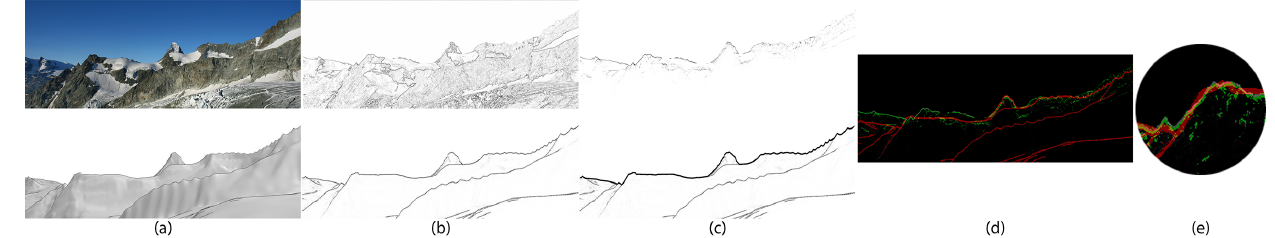
Figure 3. Example of the orientation and mountain peak identification procedure: (a) input image (top) and corresponding panorama (bot- tom); (b) edge maps; (c) skyline detection; (d) global alignment; (e) local alignment.